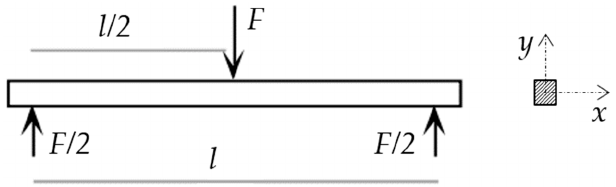
Figure 6. Three-point bending test.